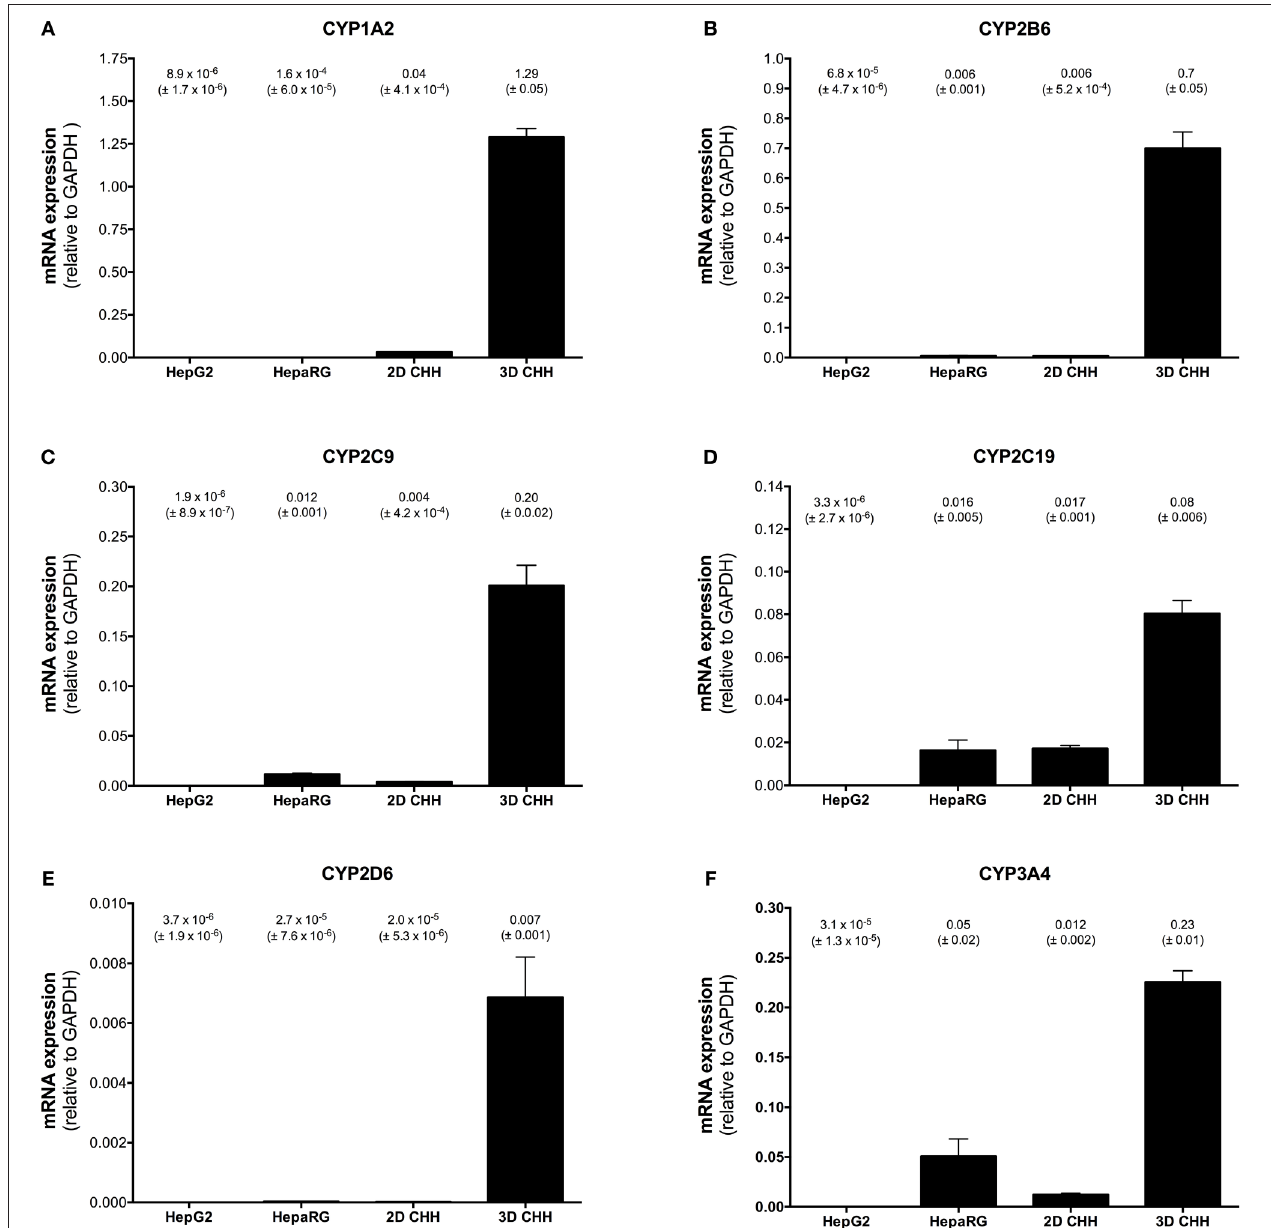
FIGURE 1 | Basal mRNA expression of CYP1A2 (A) , 2B6 (B) , 2C9 (C) , 2C19 (D) , 2D6 (E) , and 3A4 (F) in HepG2, HepaRG, 2D-, and 3D-cultured primary cryopreserved human hepatocytes. mRNA expression was determined by rt-PCR as described in the Materials and Methods Section. Results are expressed as mean ± SEM relative to GAPDH of at least three independent experiments. PHH, primary human